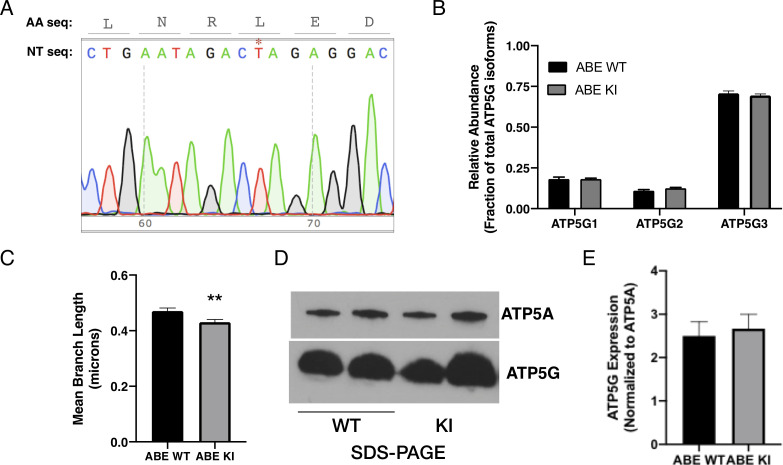
Additional data for ABE cell lines.(A) Sequencing data from an unsuccessfully edited clonal AGS cell line demonstrating the preservation of the wild-type sequence (* indicates wild-type thymidine). (B) qRT-PCR for ATP5G1, ATP5G2, and ATP5G3 demonstrating the same relative abundance of ATP5G1 in ABE WT and ABE KI NPCs. Data are means ± SEM from three independent experiments performed in triplicate. (C) Mean branch length of mitochondrial networks of ABE AGS NPCs expressing mCherry-mito7. Data obtained from 30 cells/genotype. (D) Representative western blot images and (E) quantification demonstrating the relative abundance of ATP5G and ATP5A proteins are similar in ABE WT and ABE KI cells. Quantification of western blots from four independent experiments with 2–3 replicates each. **p<0.01.